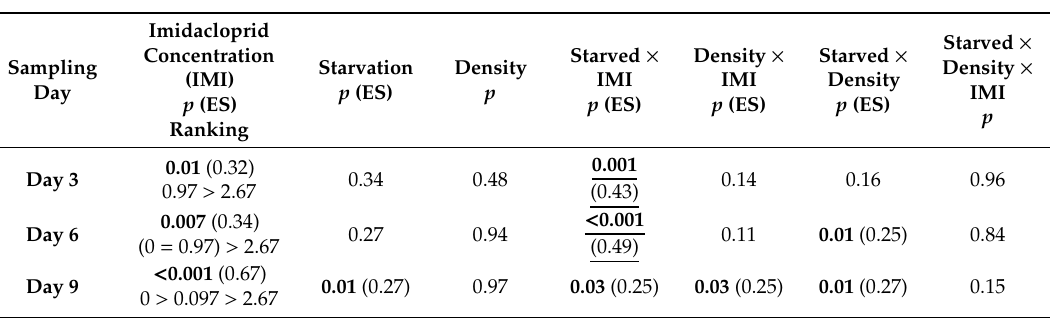
Table 2. Results of three-way ANOVAs comparing the ‘survivorship’ response between experimental treatments. p -values < 0.05 are in bold text, and e ff ect sizes (ES; partial η 2 values; range 0–1) are given in brackets where p < 0.10. Two interactions that overrode main e ff ects of imidacloprid (due to a larger e ff ect size) are underlined. E ff ect size categories are: ‘trivial’ < 0.1, ‘small’ > 0.1, ‘medium’ > 0.3, ‘large’ > 0.5 [59]. Treatment level rankings for significant main e ff ects of imidacloprid are based on significant di ff erences determined in pairwise comparisons using post-hoc tests. Imidacloprid concentrations